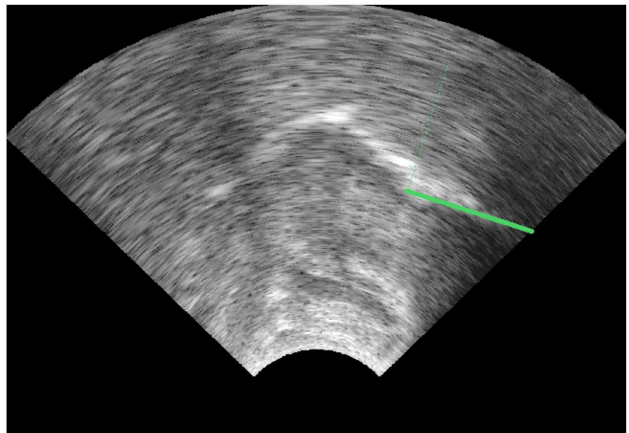
Figure 13. Image of the tongue pressed against a bite-plate and a green fiducial line superimposed. All coordinates were rotated so that the green line formed the horizontal